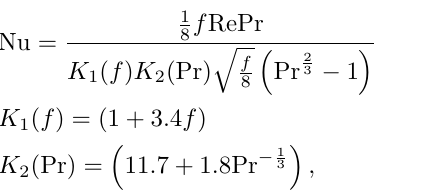
Figure 3. Radially-azimuthal view of the one-eighth of the pin type square annular geometry geometry (with adjacent subchannels). from analytical solutions, experimental data, nuclear and benchmark calculations (code-to-code compar-